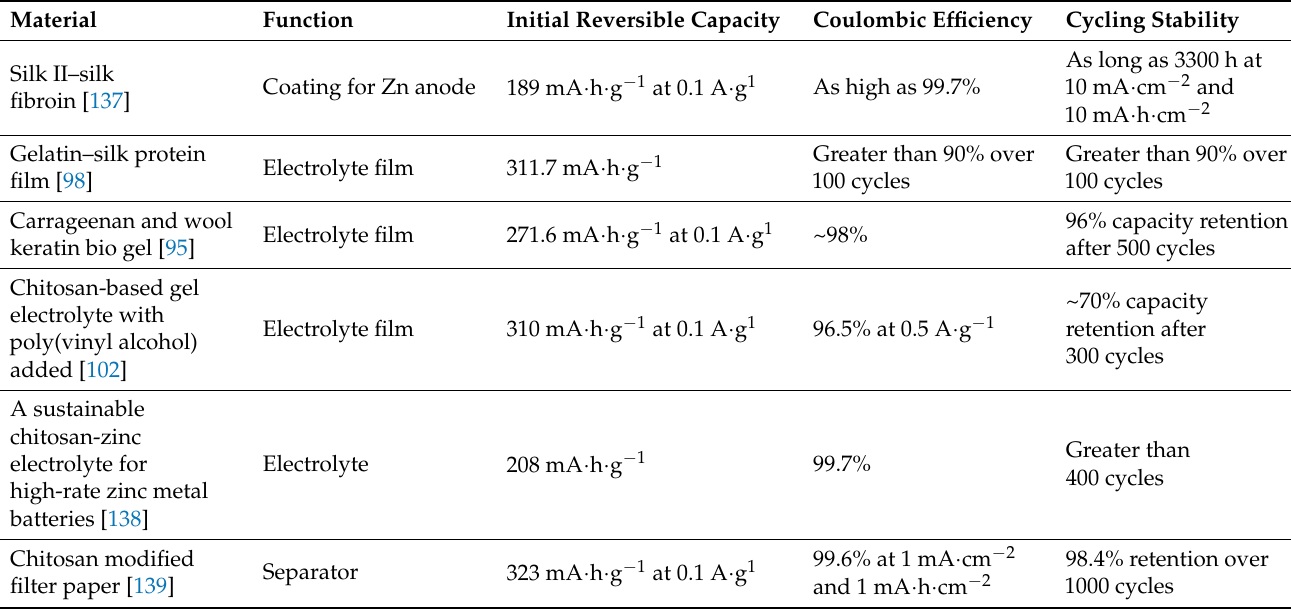
Table 3. Biopolymer applications as zinc battery